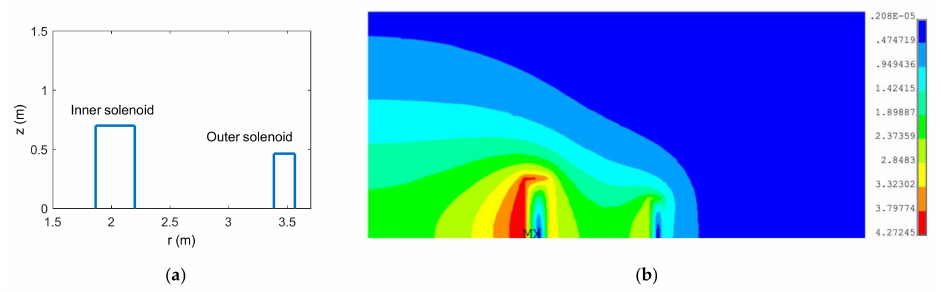
Figure 2. The magnetic field distribution for a design scheme of SMES with current density of 20 MA/m 2 , ( a ) the design scheme (symmetric about the x-axis), and ( b ) the corresponding magnetic field obtained from